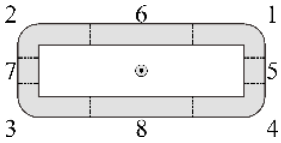
Figure 9. The extension from the label preference rank in the fixed-position model.